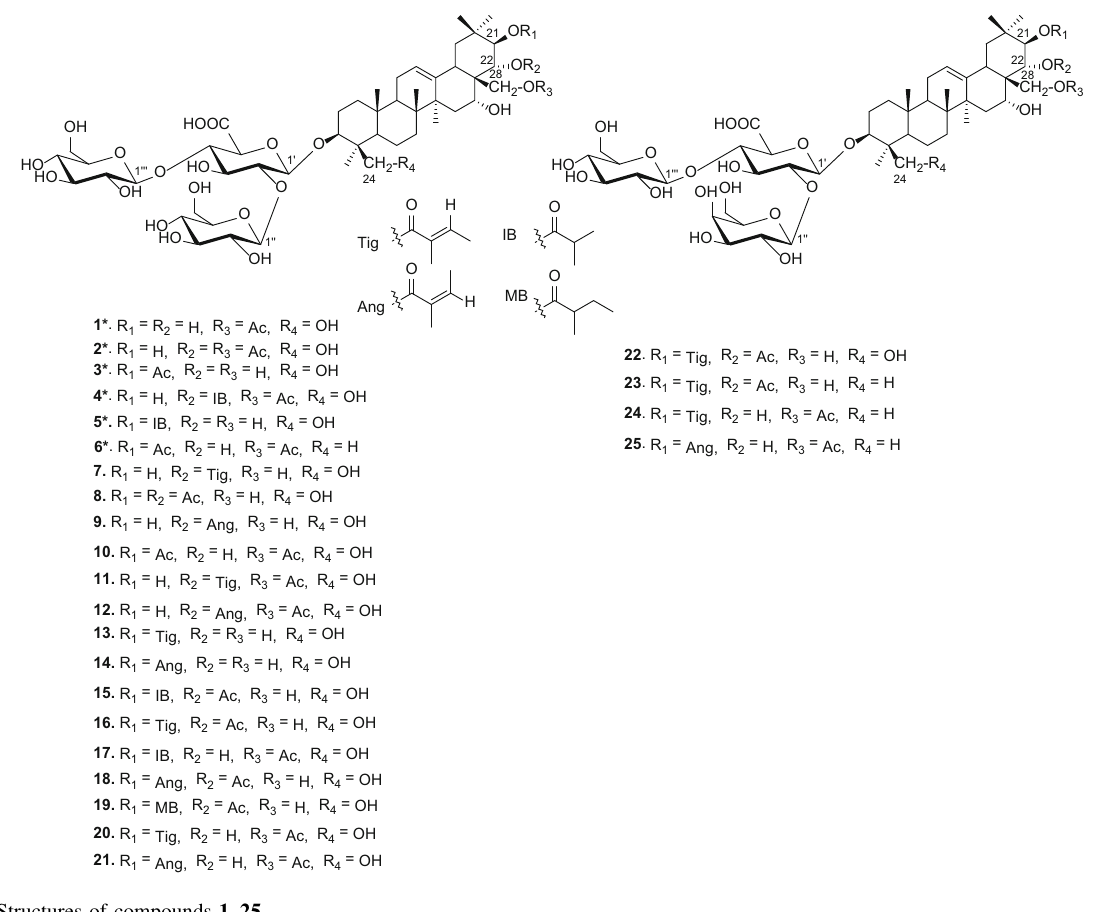
Fig. 1 Structures of compounds 1 –